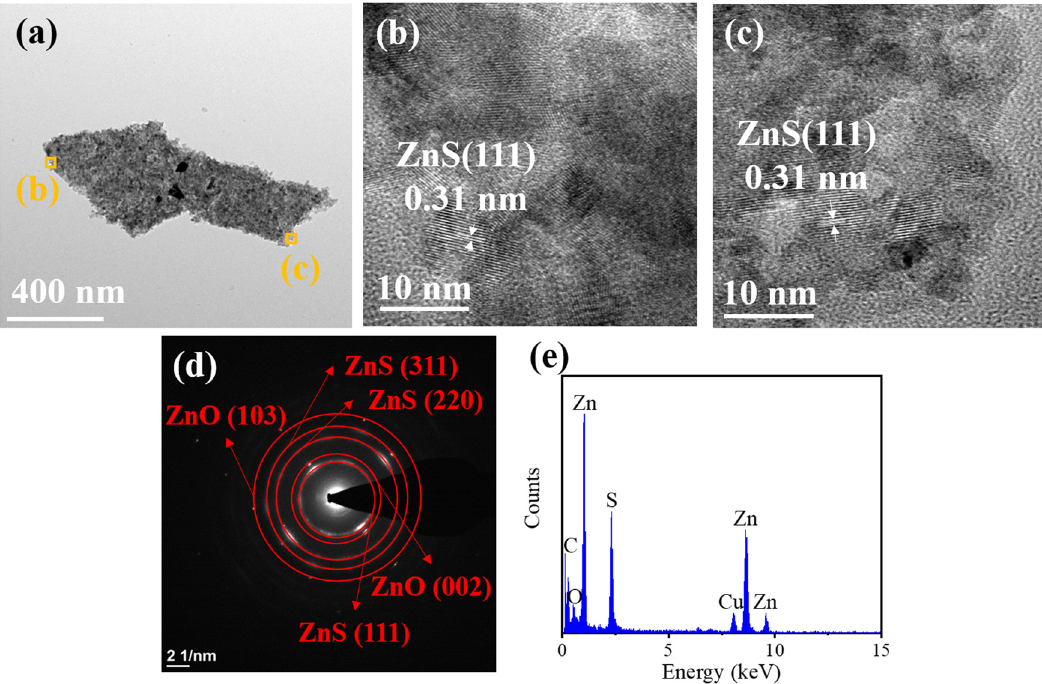
Figure 5: TEM analysis of the ZS - 3: ( a ) low - magni fi cation image. ( b ) and ( c ) HRTEM images of various local regions in image ( a ) . ( d ) SAED pattern. ( e ) EDS